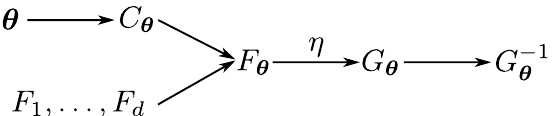
. The joint CDF F θ is ob- θ